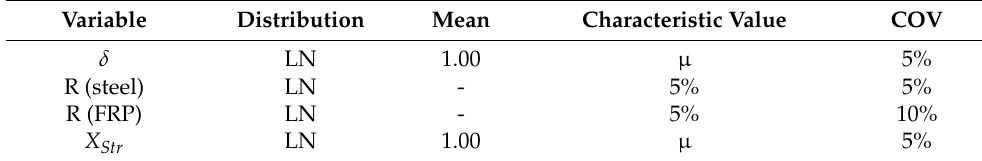
Table 2. Stochastic model for the resistance variables. LN: Lognormal